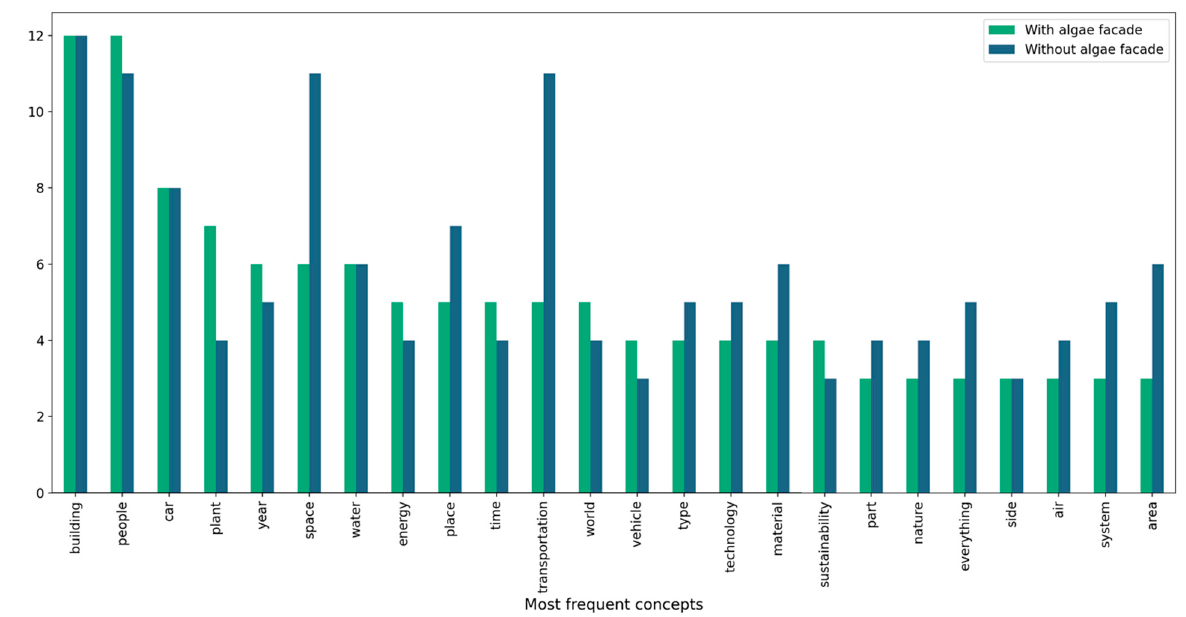
Figure 7. Frequency of concepts for the brainstorming tasks in a room with an algae facade and without an algae façade.